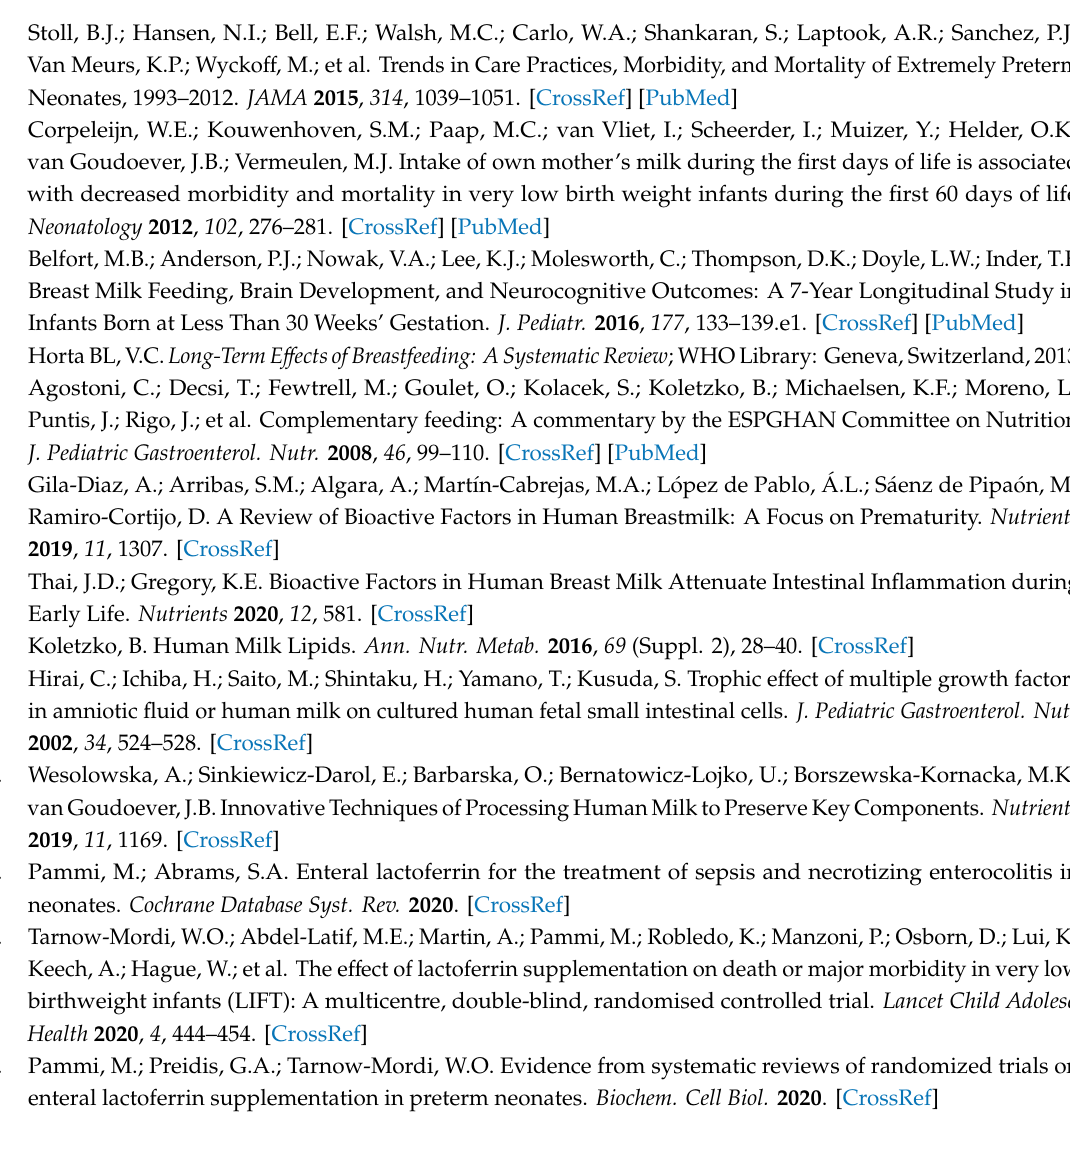
Table S1: Search strategy in MEDLINE, EMBASE, and CENTRAL. Table S2: Overview of ongoing or recently completed studies investigating the e ff ect of bovine colostrum or